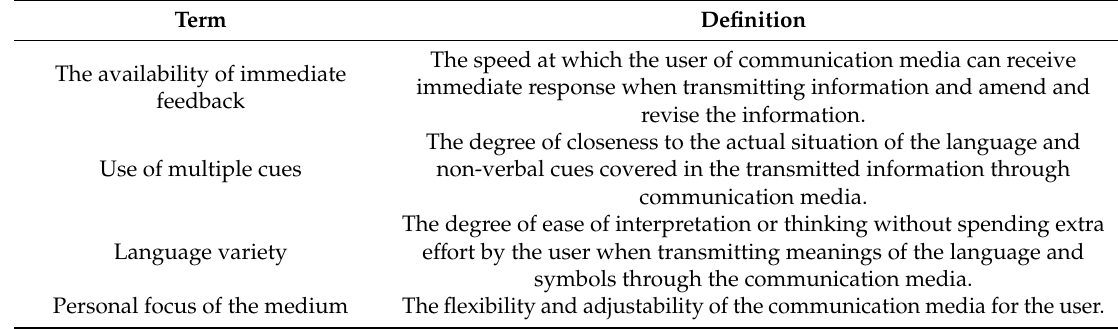
Table 1. Definitions of key terms related to media richness.